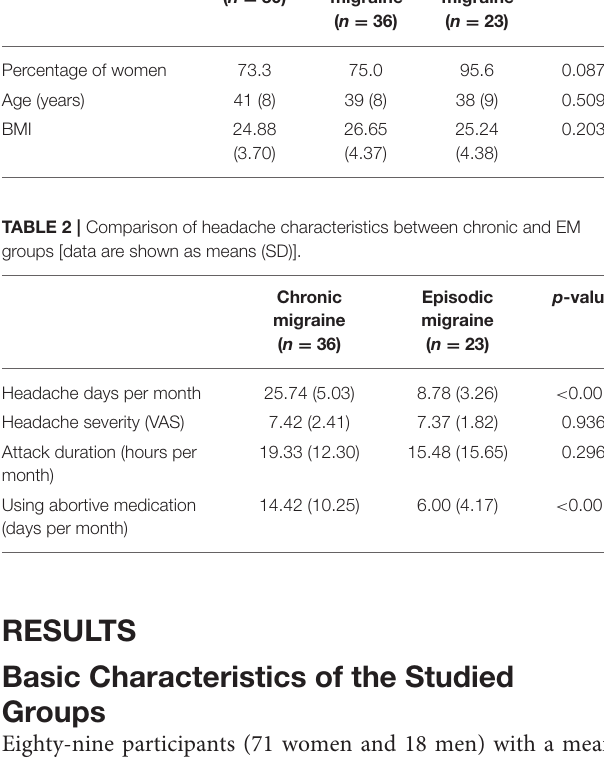
TABLE 1 | Comparison of gender, age, and BMI between the studied groups [data are shown as means (SD)]. Variable